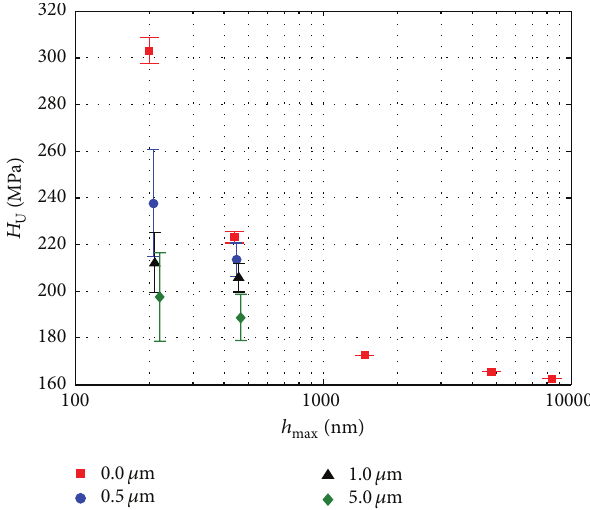
Figure 17: Universal hardness of PS when the first 0.5, 1, and 5 𝜇 m layers of the top surface are removed [28].